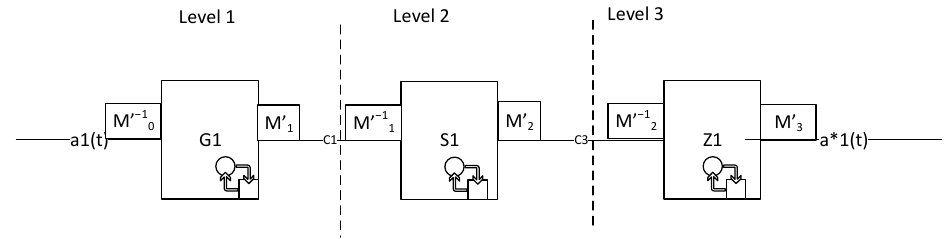
Figure 3. Dedicated logical transmission channel i1 in the control system.